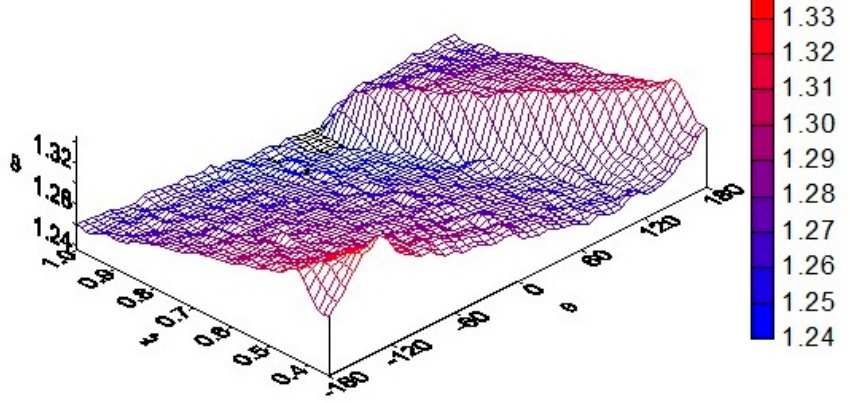
Figure 7. The 3-D radial-angular instantaneous distribution of function ϑ in the cross-section ζ = 0.5.